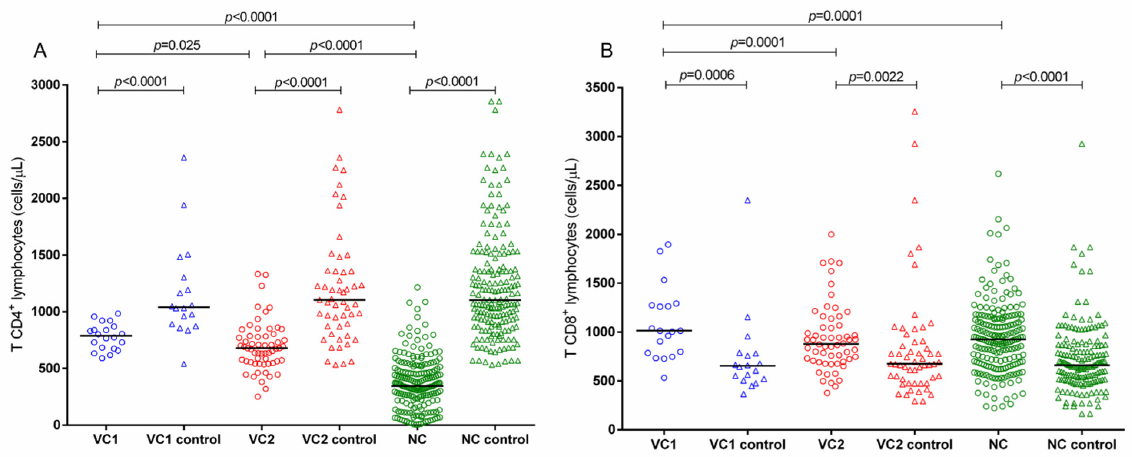
Figure 2. Comparison of ( A ) CD4+ TL counts and ( B ) CD8+ TL counts between non-infected and HIV-1 infected persons, according to the control progression of infection.